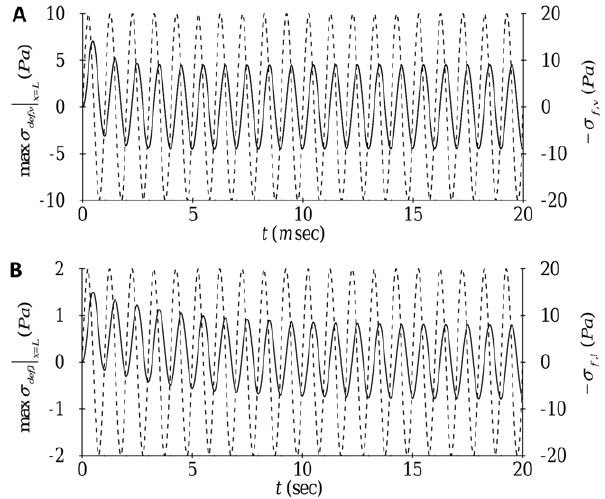
Figure 6. Effect of the forcing frequency on the amplitude of the deformation-related stress at the nucleus ( x ~ L ):––––, transverse motion; - - - -, axial motion.